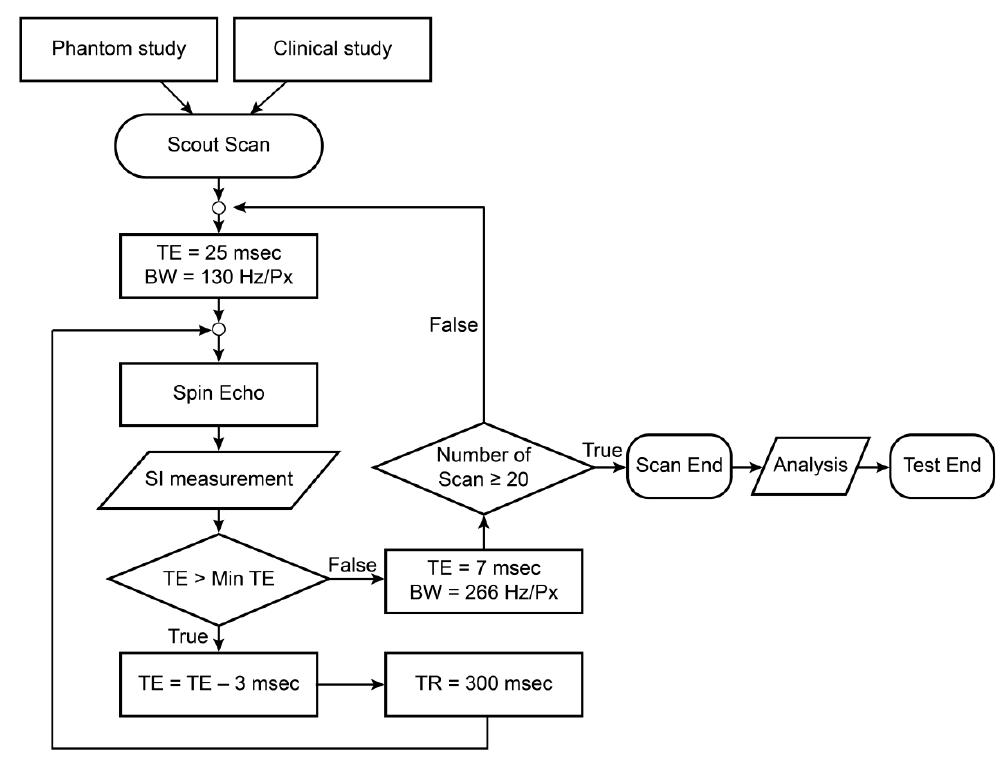
Figure 2. Study flowchart. TE, echo time; BW, bandwidth; TR, response time.